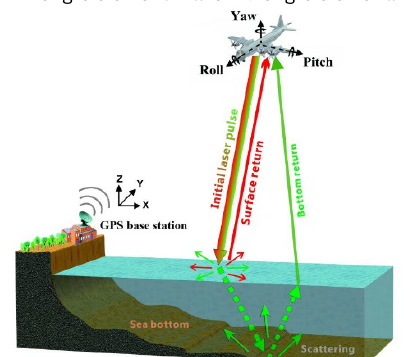
Figure 1. Dual LiDAR working